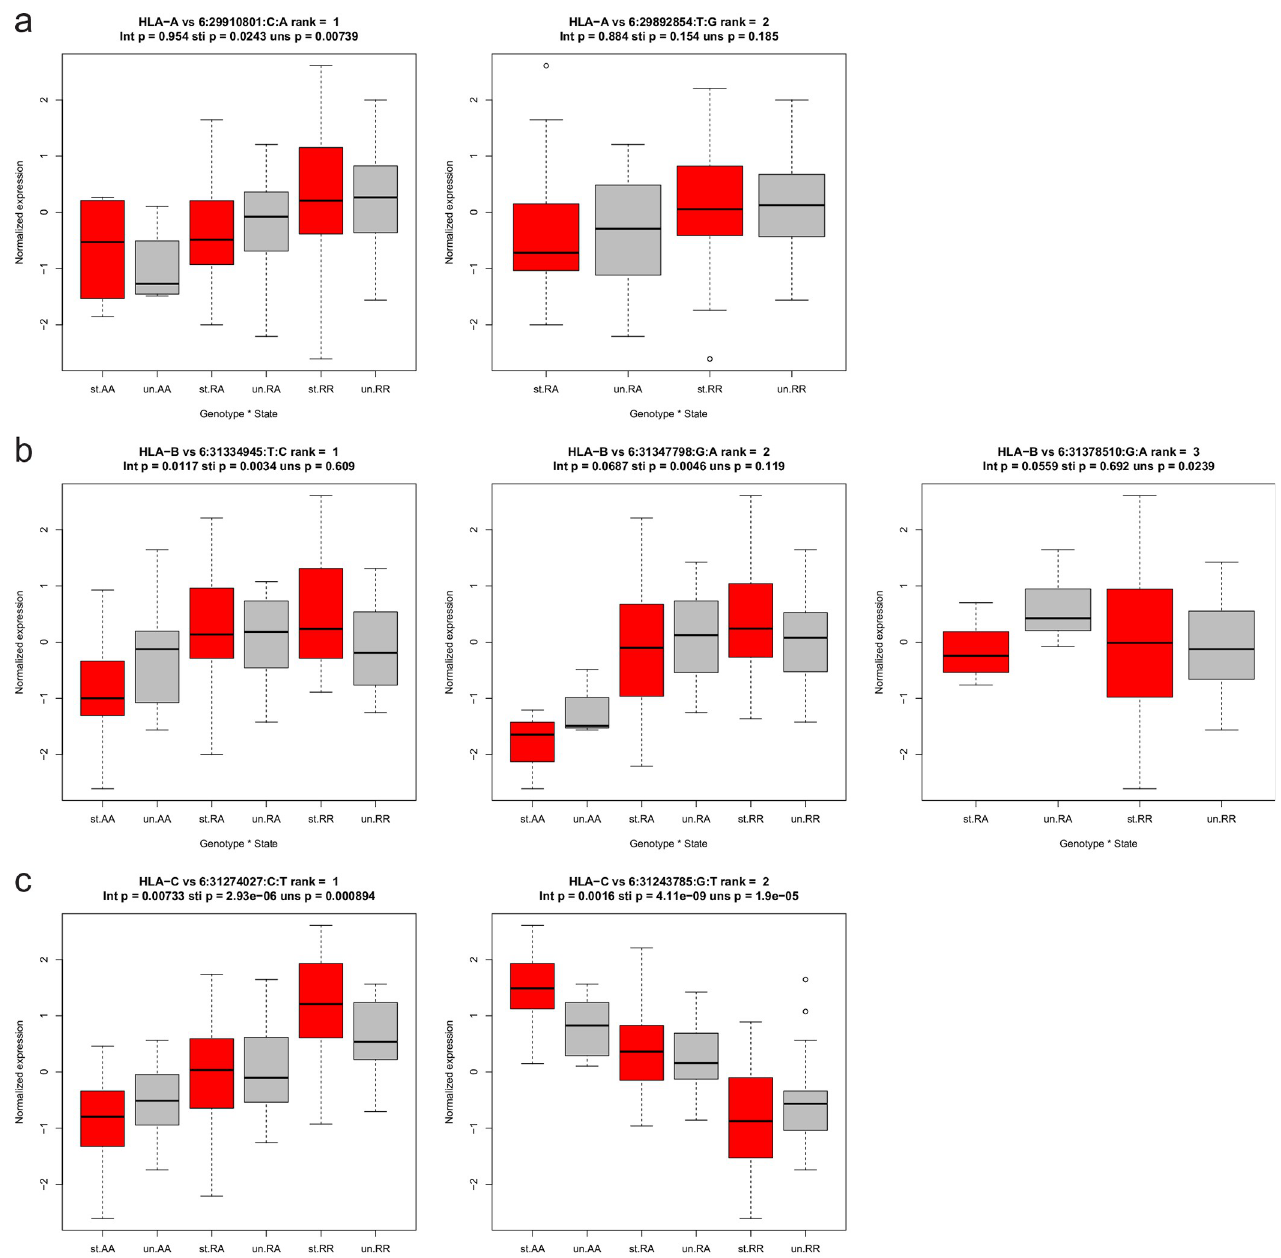
Fig 7. Association between eQTL genotypes and HLA expression in unstimulated versus stimulated PBMCs. Interaction analysis boxplots showing the association between the independent eQTL genotypes (AA = homozygous alternative, RA = heterozygous, RR = homozygous reference) and normalized expression for HLA-A ( a ), HLA-B ( b ), and HLA-C ( c ). The stimulated cells are shown in red, and the unstimulated cells are in grey. The interaction p-value and the p-values in stimulated and unstimulated cells are provided in the titles of the